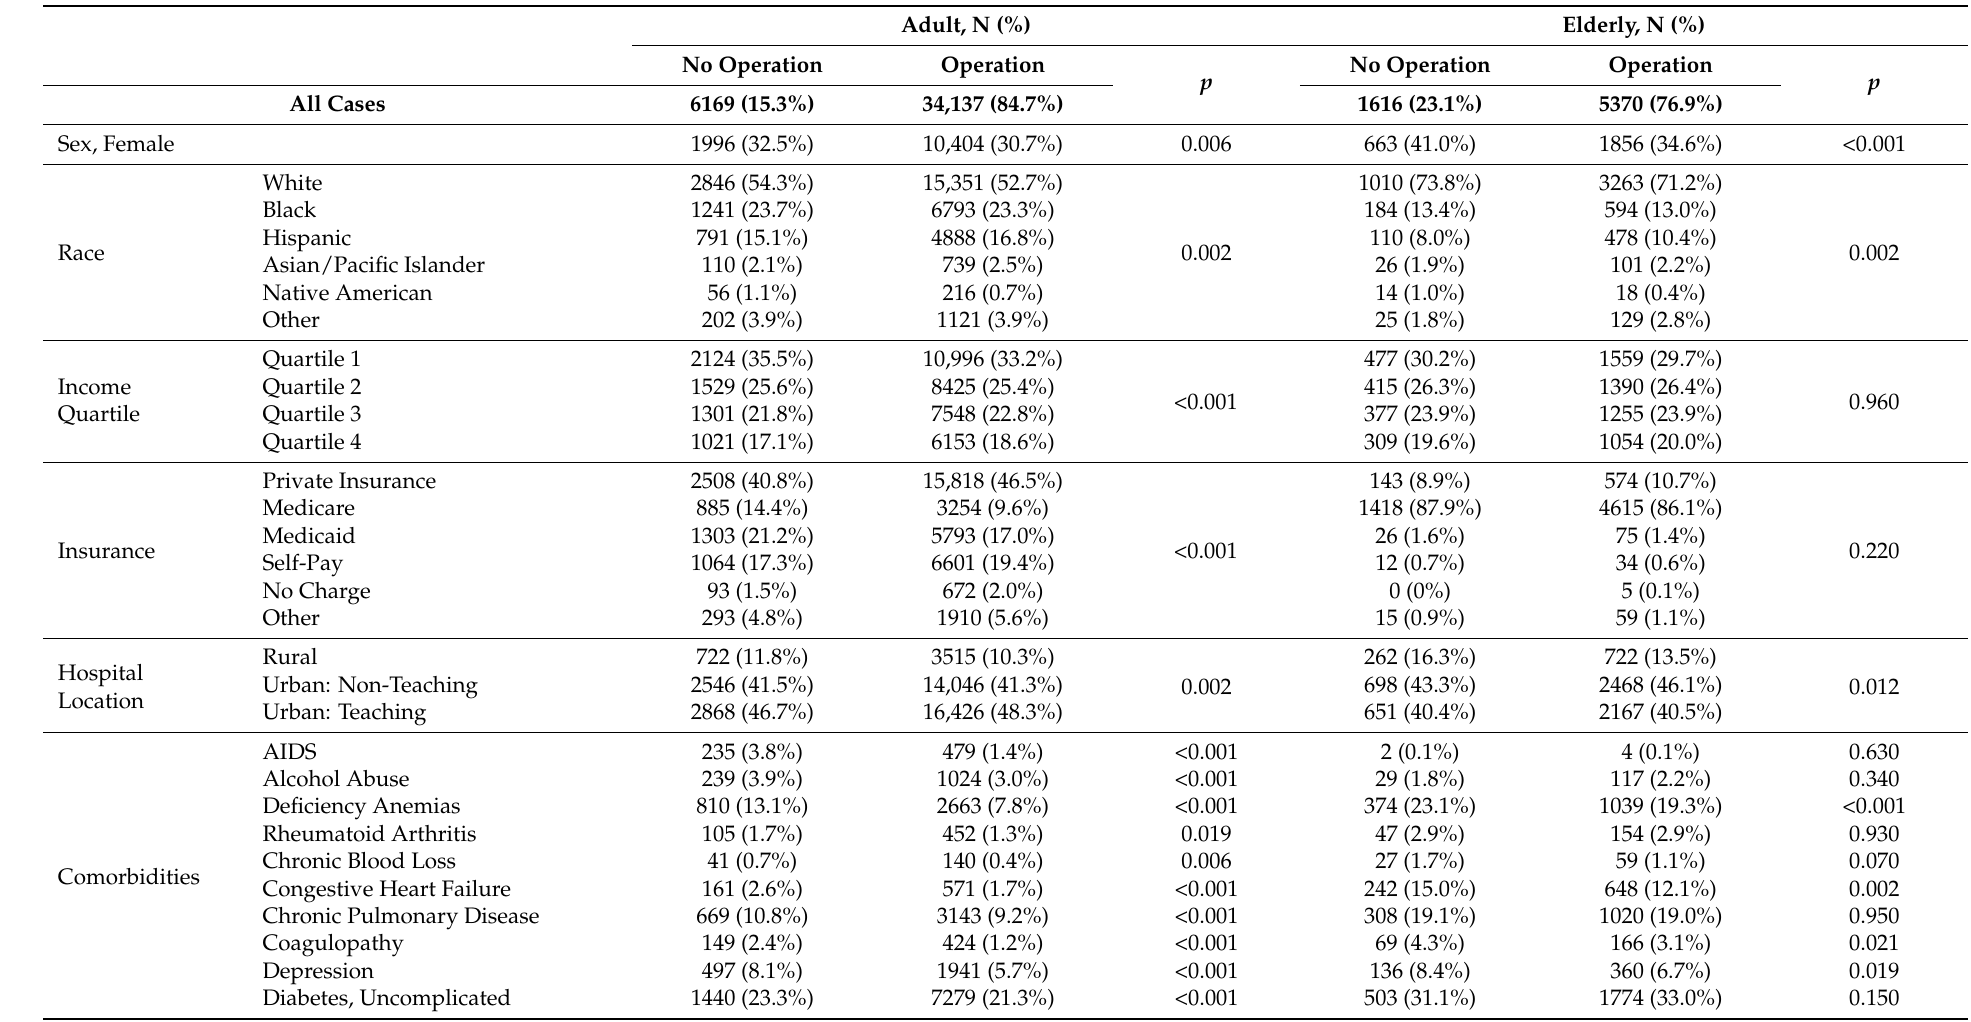
Table 2. Characteristics of emergently admitted patients with the primary diagnosis of abscess of anal/rectal regions. Data are stratified according to operation status, NIS